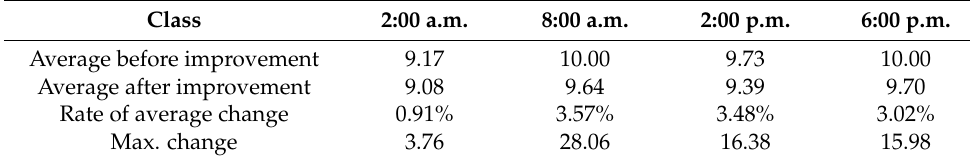
Table 1. Statistics of accessibility calculated by the two methods (Wuhan, China, 2022).